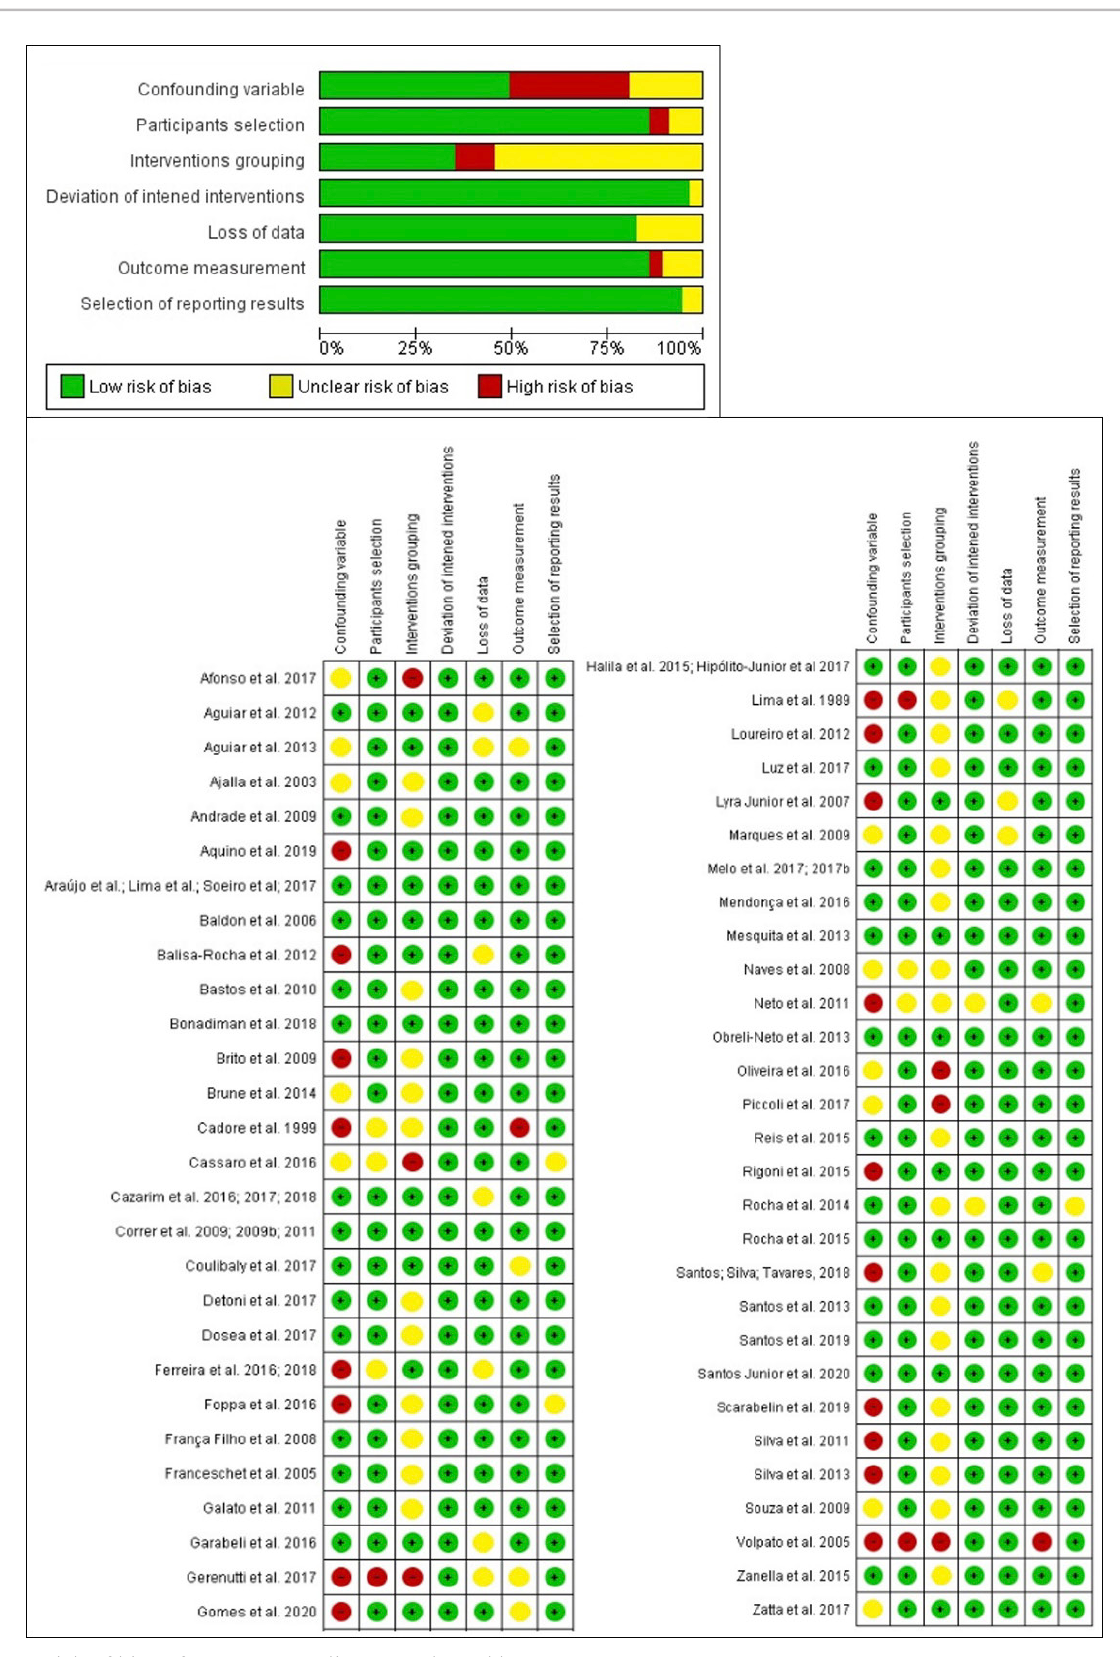
FIGURE 4 - Risk of bias of non-RCT studies as evaluated by